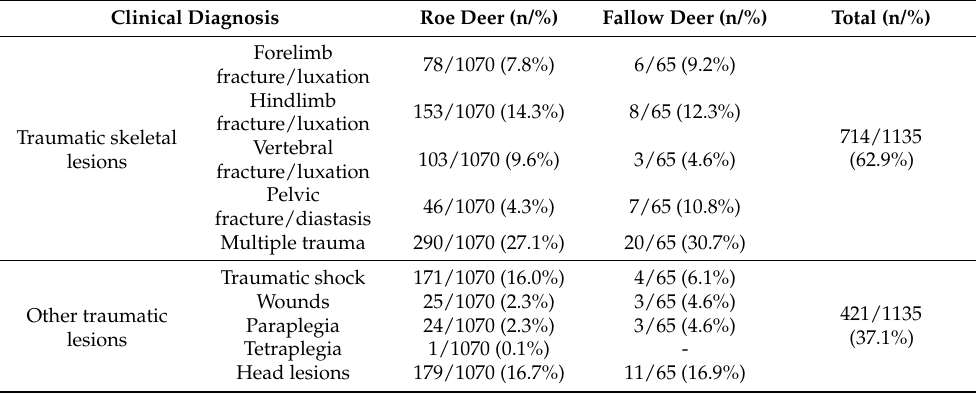
Table 5. Clinical diagnosis expressed as the number and proportions (n/%) of roe deer, fallow deer, and total